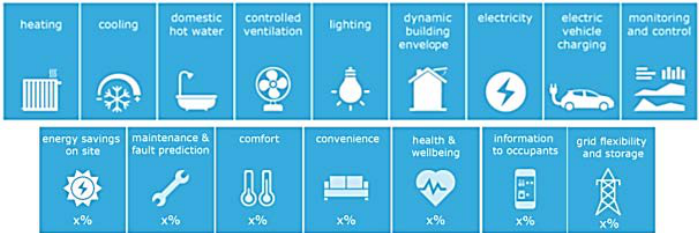
Figure 1. Domains and impact criteria for the SRI methodology [24].